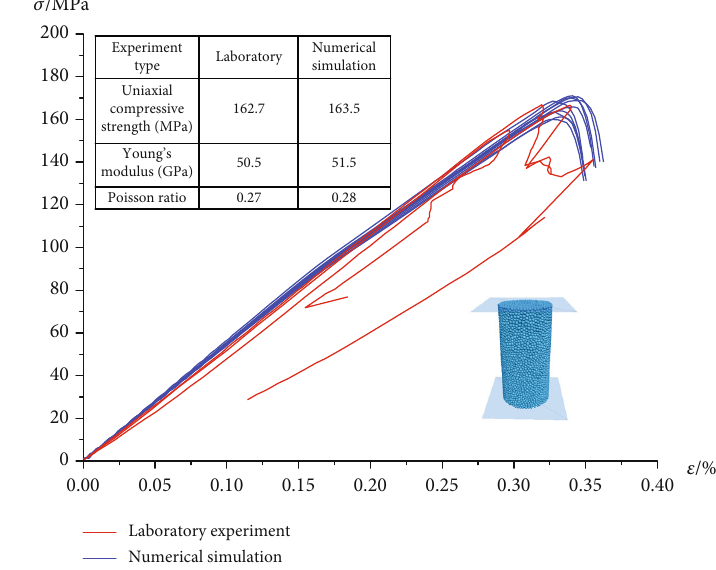
Figure 7: Uniaxial compression test and numerical